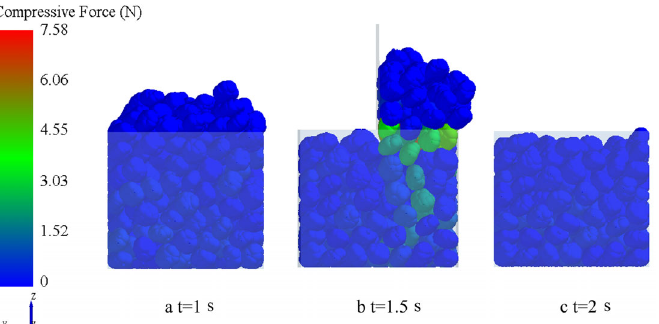
Figure 18. Snapshots of the simulation of the bulk density test of Jinong 3 seeds using the 11 ‐ sphere model.